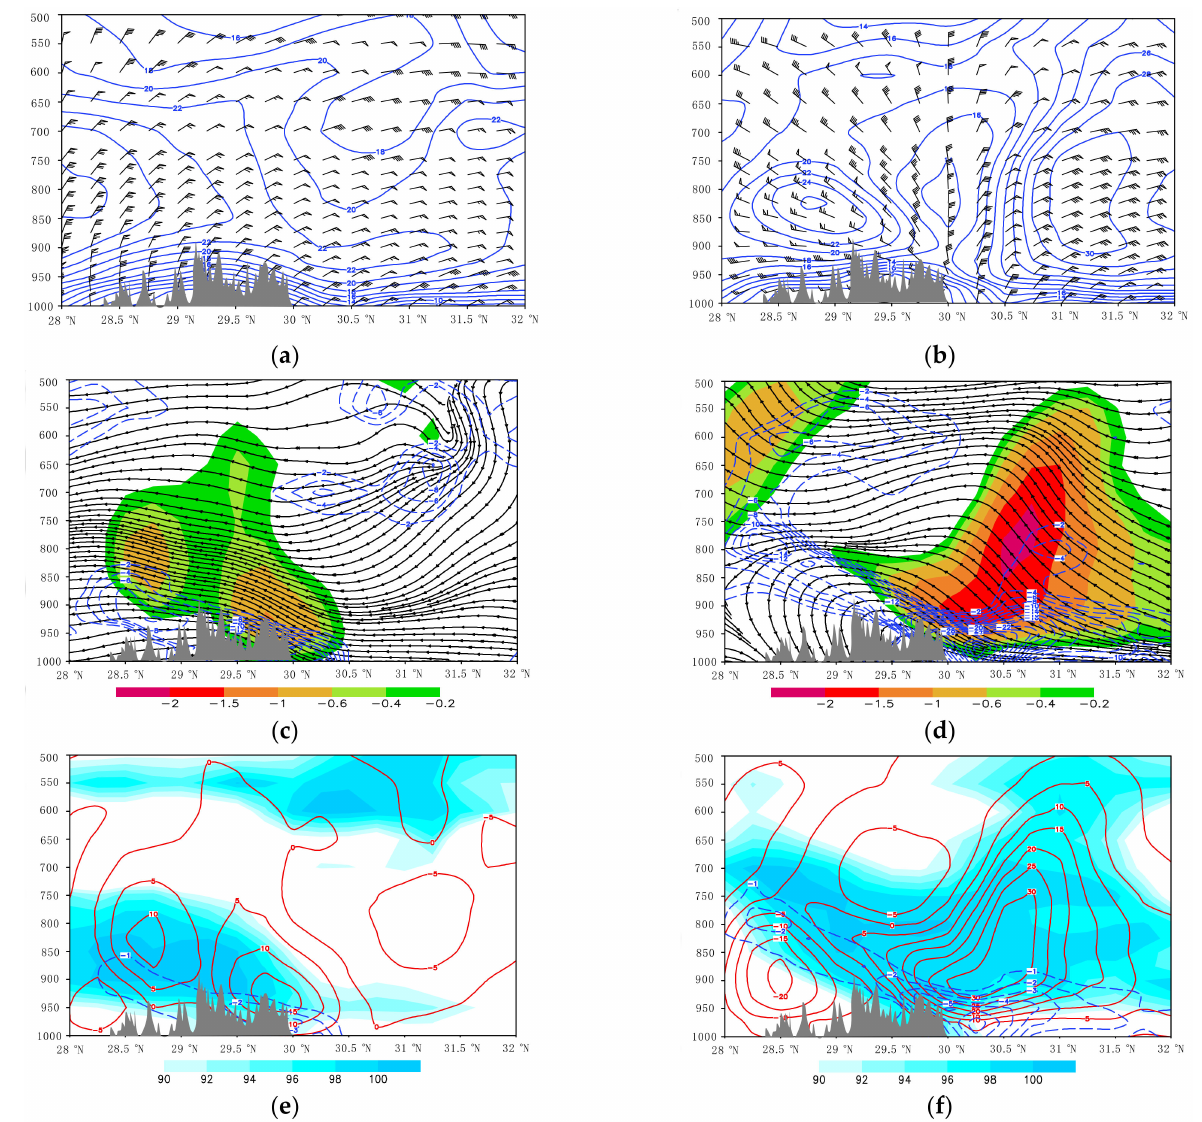
Figure 14. Vertical cross-section of ( a , b ) horizontal wind barb (streamline) and wind speed (blue line, unit: m s − 1 ), ( c , d ) meridional vertical circulation (streamline), vertical velocity (shaded, unit: Pa s − 1 ) and divergence (blue dashed line, unit: 10 − 6 s − 1 ), ( e , f ) horizontal water vapor flux divergence (blue dashed line, unit: 10 − 9 g cm − 2 hPa − 1 s − 1 ), relative humidity (shaded, unit: %), and vertical water vapor flux (red line, unit: 10 − 6 g cm − 1 hPa − 1 s − 1 ) along 121.147 ◦ E. (left column) 1400 BT on 24 July 2021,and (right column) 2000 BT on 25 July 2021. The gray color indicates the terrain